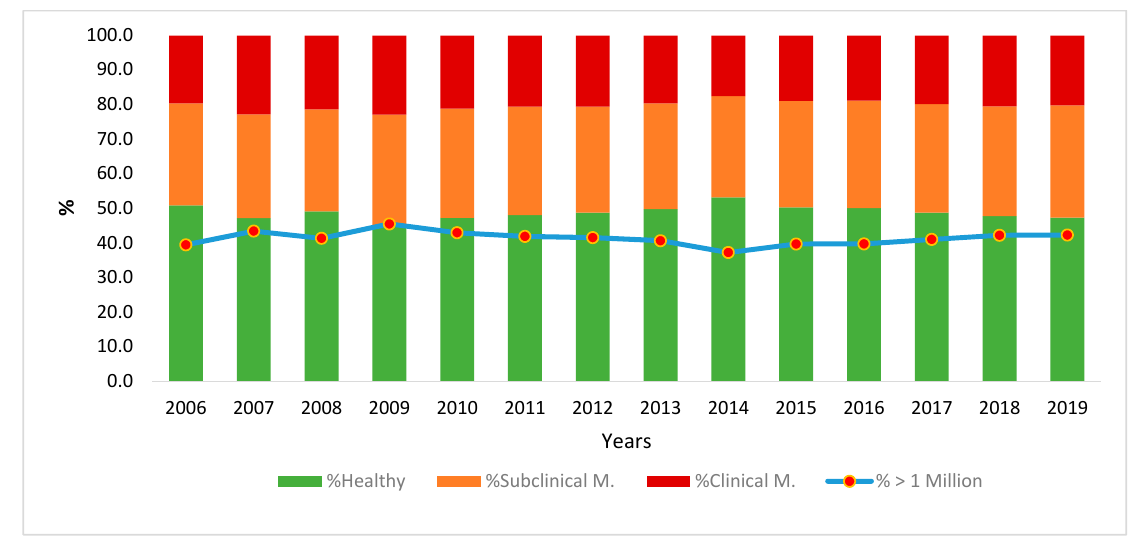
Figure 3. Estimation of the evolution of subclinical and clinical mastitis throughout the study period (or absence of mastitis) based on criteria of Paape et al., 2001 (healthy/>1 million suspected of mastitis) and Renée de Crémoux, 2012 (healthy, subclinical, or clinical mastitis). Figure 4 shows the average evolution throughout the lactation period. The average SCC in control tests below 750,000 cells ranges from 41% (in September and October, the months with the highest incidence of mastitis) to 55% in March (the month with the lowest incidence). The incidence of clinical mastitis was higher between June to December, with over 20% of the control tests above 2 million cells, compared to the first 6 months of the year, which showed an incidence of under 20%, while the incidence of subclinical mastitis exceeded 30% in the tests from July to October, with just under 45% of the tests surpassing the 1 million cell mark. Finally, the months of June to December presented the highest levels of suspected mastitis in the tests according to the criteria of Paape et al. [20], with over 40% of the tests above the level of one million cells/mL. Of these, the months of Sep- tember and October were the worst, with almost 50% of the tests above the one million cell level.